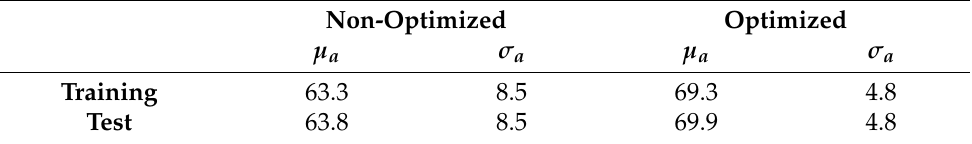
Table 3. Balanced accuracy (average µ a and standard deviation σ a in %) obtained by working with the training and test datasets of the MNIST database for the non-optimized and the optimized programming